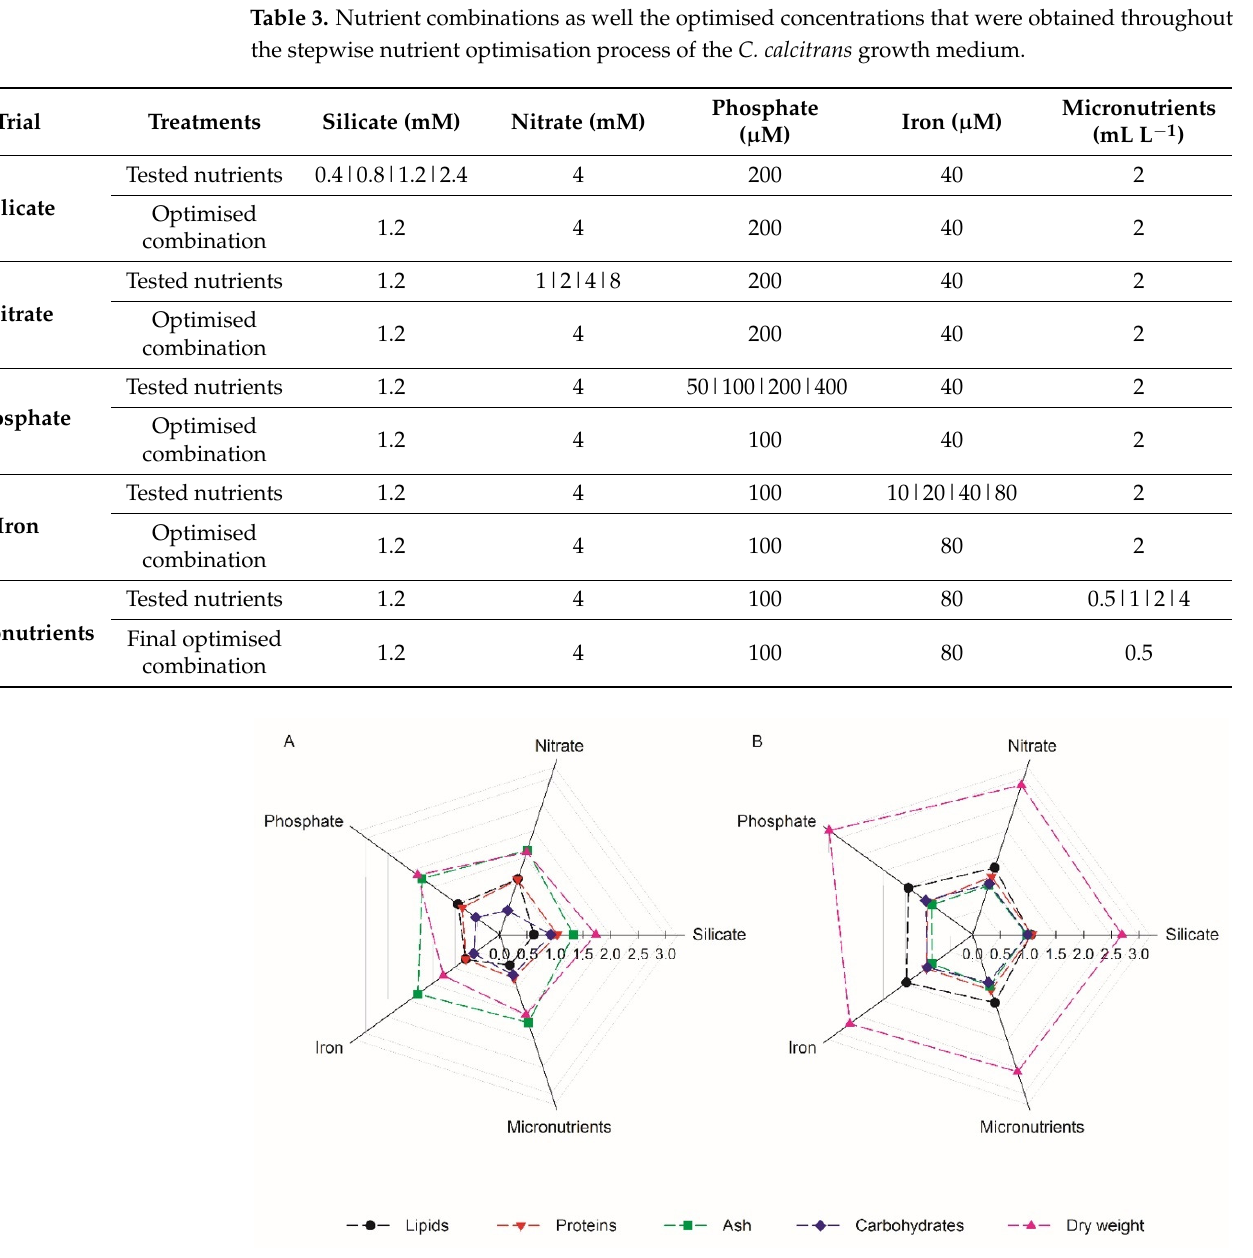
Figure 5. Proximal composition of optimised biomasses of diatoms S. costatum ( A ) and C. calcitrans ( B ) that were grown in bubble column PBR system, regarding the dry weight as well as the total protein, lipid, ash, and carbohydrate contents ( n = 3). The values are represented as the means ratios to the control conditions.